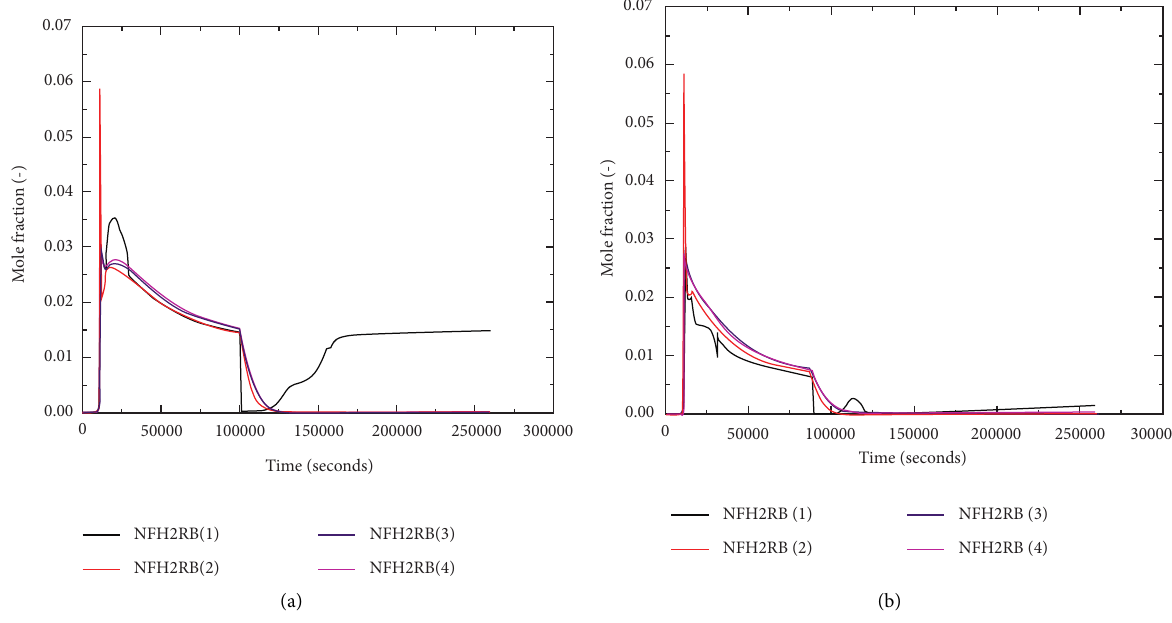
Figure 20: Mole fraction of hydrogen for each compartment: (a) without PAR modeling and (b) with PAR modeling.